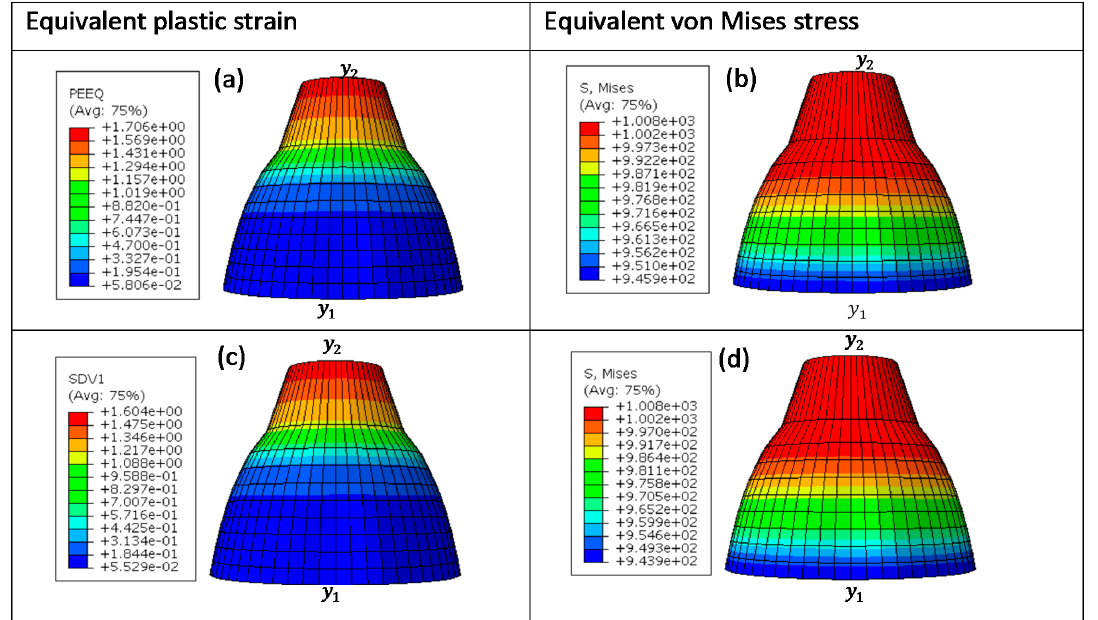
Figure 14. Numerical estimation of ( a , c ) equivalent plastic strain and ( b , d ) equivalent von Mises stress distribution in ( a , b ) VUHARD and ( c , d ) VUMAT subroutines developed here, using 1 mm mesh size, at a test velocity of 4 m/s and temperature of 298 K.